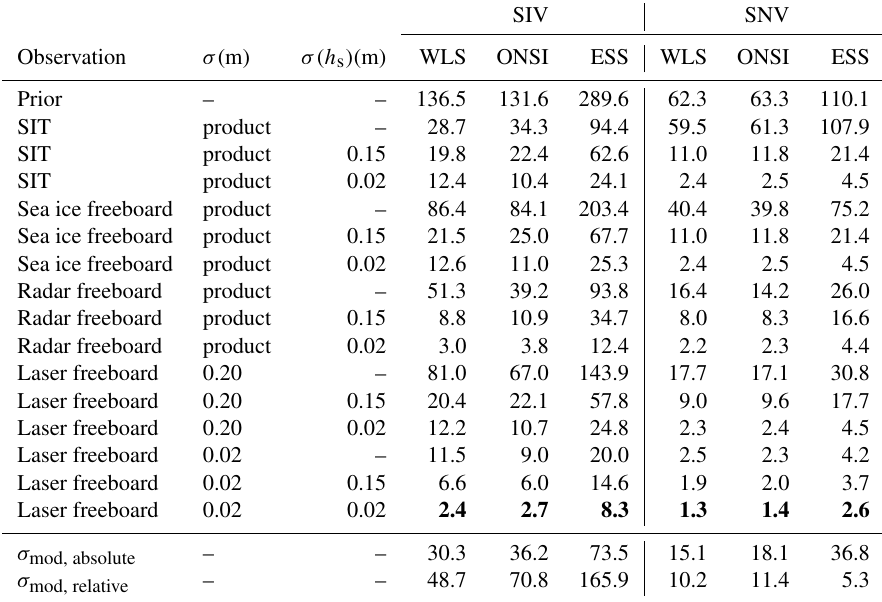
Table 3. Prior and posterior uncertainties of sea ice volume (SIV, columns 4–6) and snow volume (SNV, columns 7–9) respectively for three regions in km 3 . Column 1 indicates observation, column 2 indicates uncertainty range (“product” refers to uncertainty specification provided with product), column 3 indicates uncertainty range of additional hypothetical snow product (a dash means no snow product is used). In each of columns 4–9 the lowest uncertainty range is highlighted in bold. The two bottom rows give estimates for the uncertainty due to model error, i.e. the residual uncertainty with optimal control